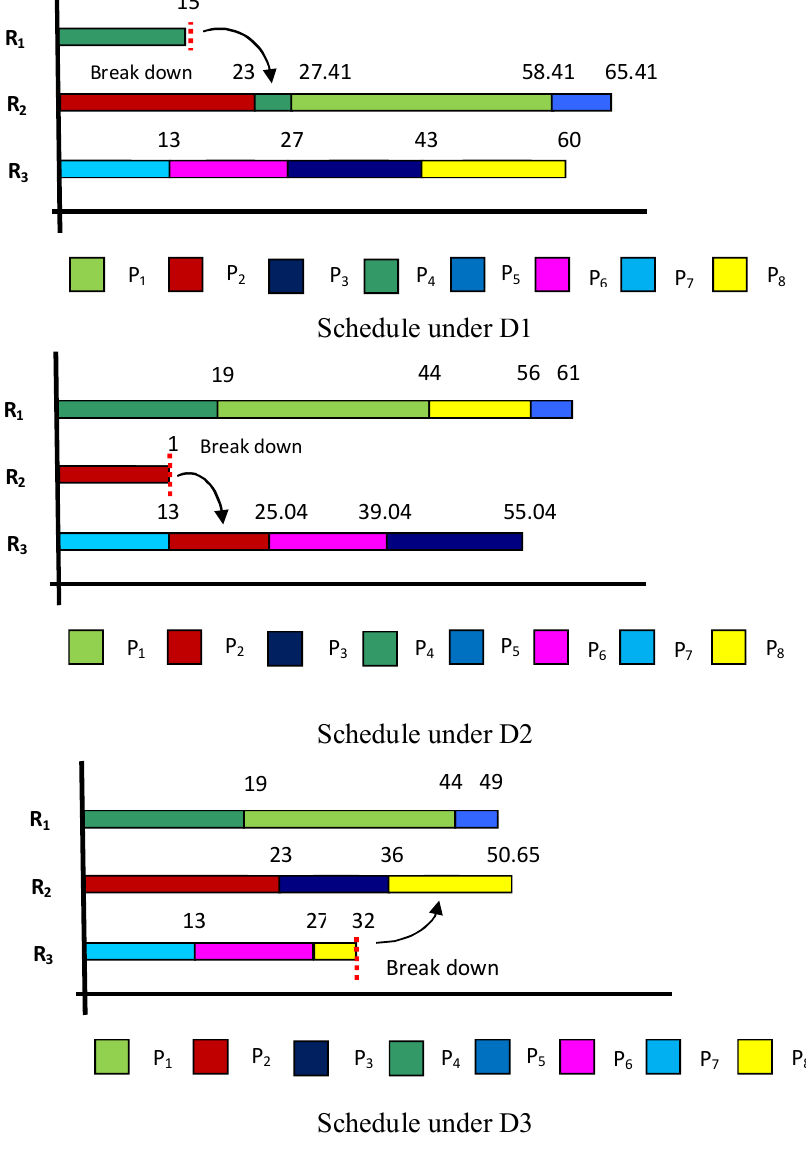
Fig. 3. Gantt charts showing schedules under the scenarios D1, D2, and D3